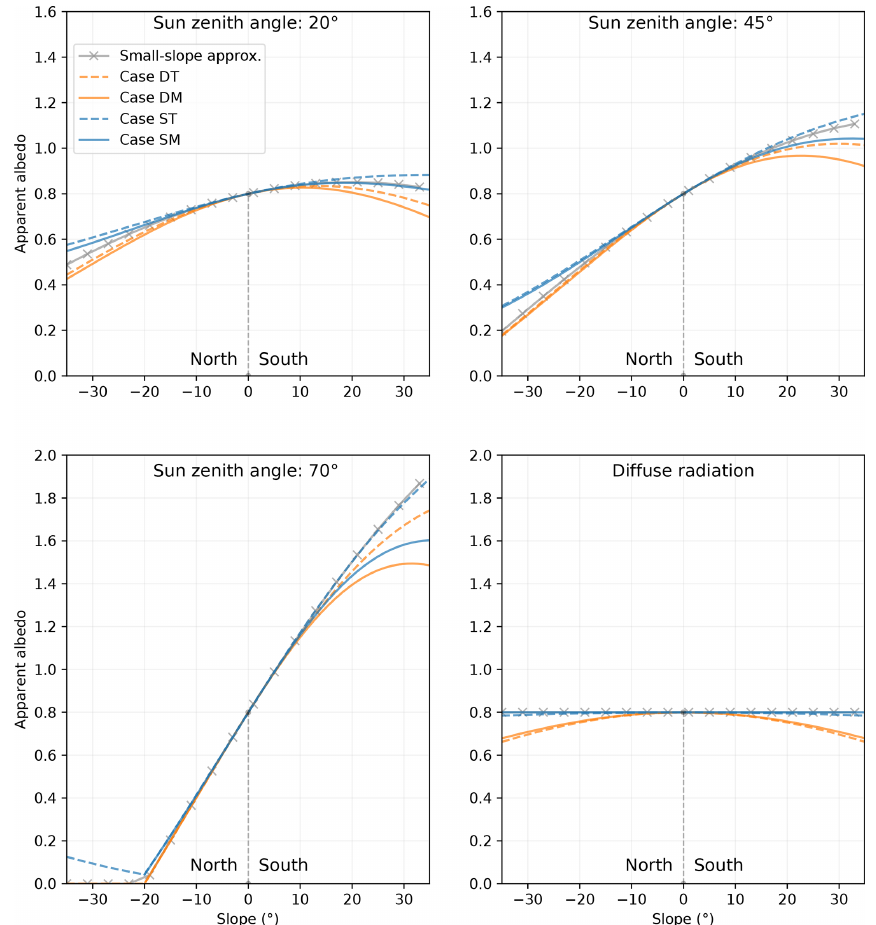
Figure 3. Apparent albedo as a function of slope computed for various formulation and different illumination conditions. The flat albedo is here fixed to 0.8 and the no diffuse radiation is